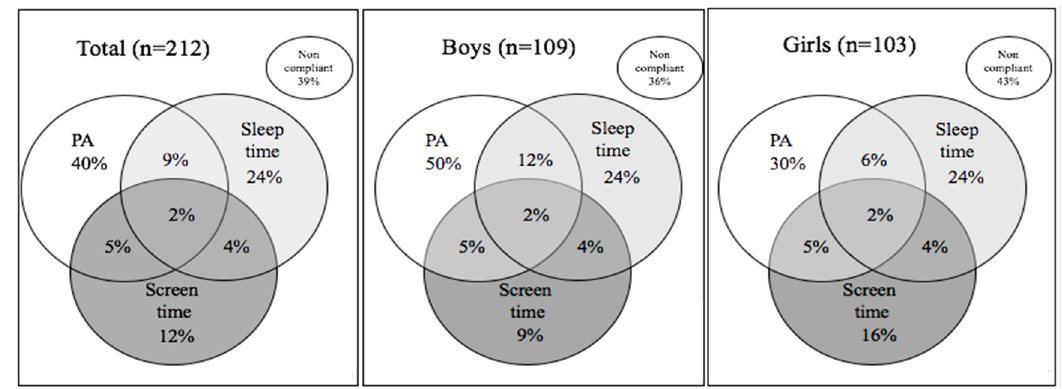
Figure 1. Venn diagrams showing the percentage of preschoolers compliant and not compliant with 24-h movement behaviors and the combinations of these guidelines for the overall sample and by sex.